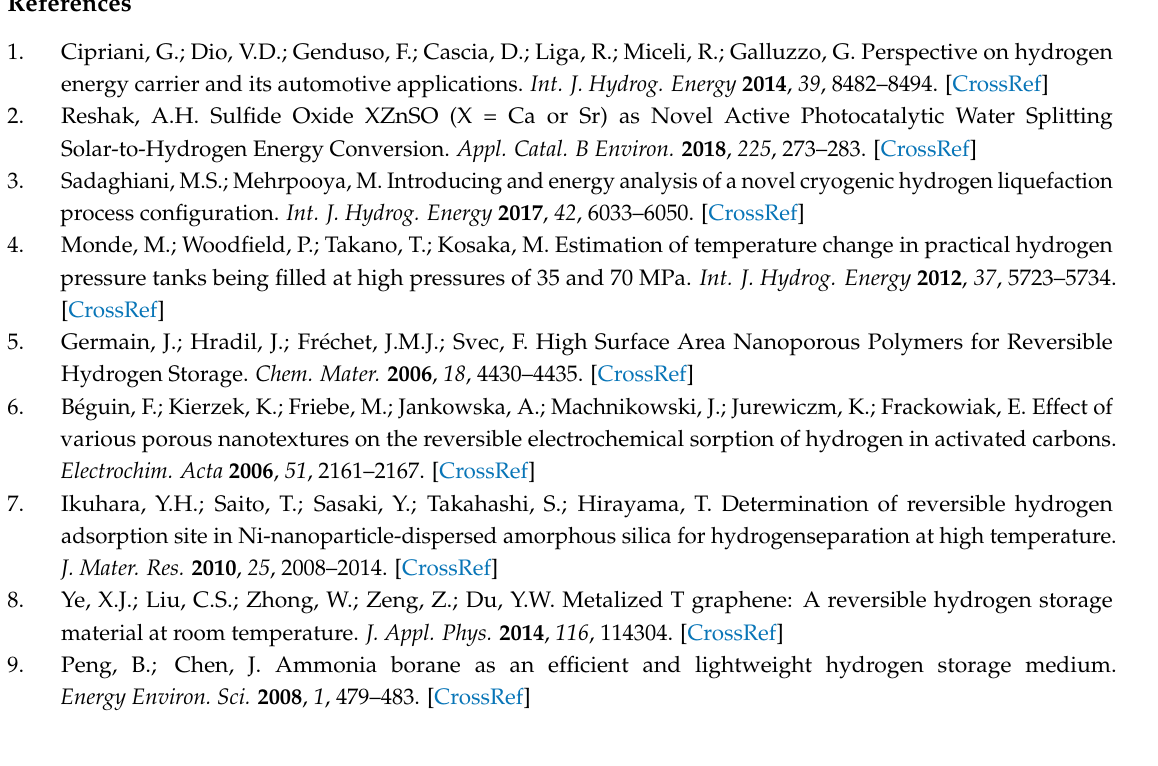
Figure S1: SEM image of the sample synthesized in the absence of SDS; Figure S2: EDX spectra of MoO 3 -doped MnCo 2 O 4 (0.10) catalysts; Figure S3: Raman spectrum of the MoO 3 -doped MnCo 2 O 4 (0.12); Figure S4: Hydrogen release from AB neutral solution in the presence of MoO 3 -doped MnCo 2 O 4 (0.10)